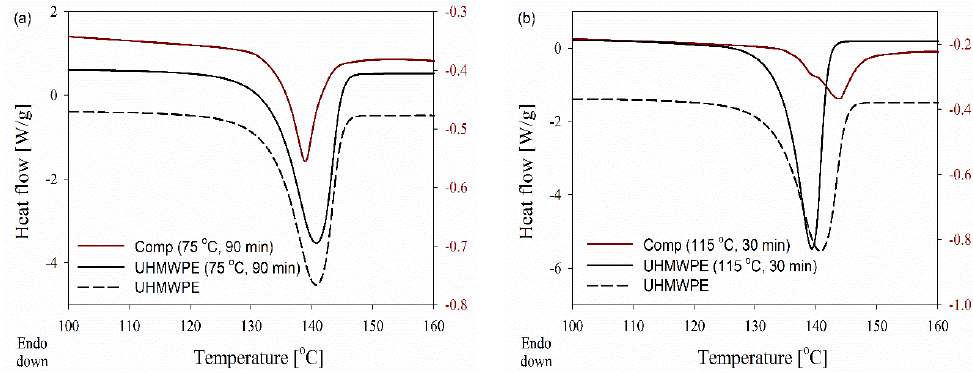
Figure 7. DSC curves obtained during the first heating of the disentangled UHMWPE and (95/5 wt.%) composite at 10 ◦ C min − 1 , where dis-UHMWPE and the composite were annealed and processed respectively at: ( a ) 75 ◦ C for 90 min, ( b ) 115 ◦ C for 30 min.